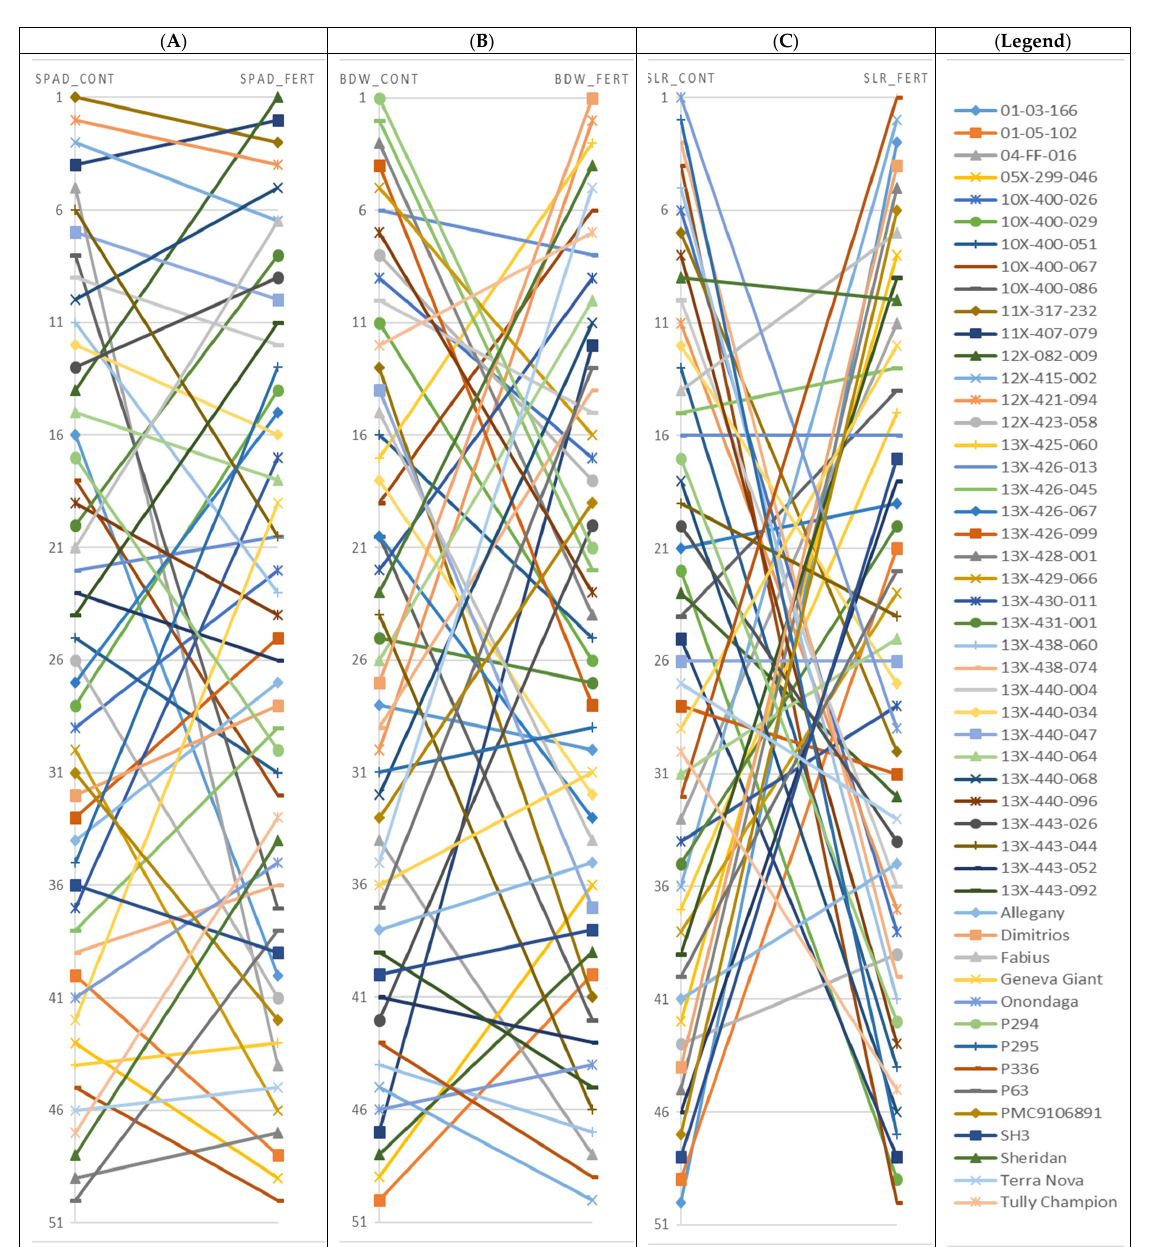
Figure A1. Ranking genotypes by ( A ) SPAD reading, ( B ) biomass dry weight (BDW), and ( C ) stem:leaf ratio